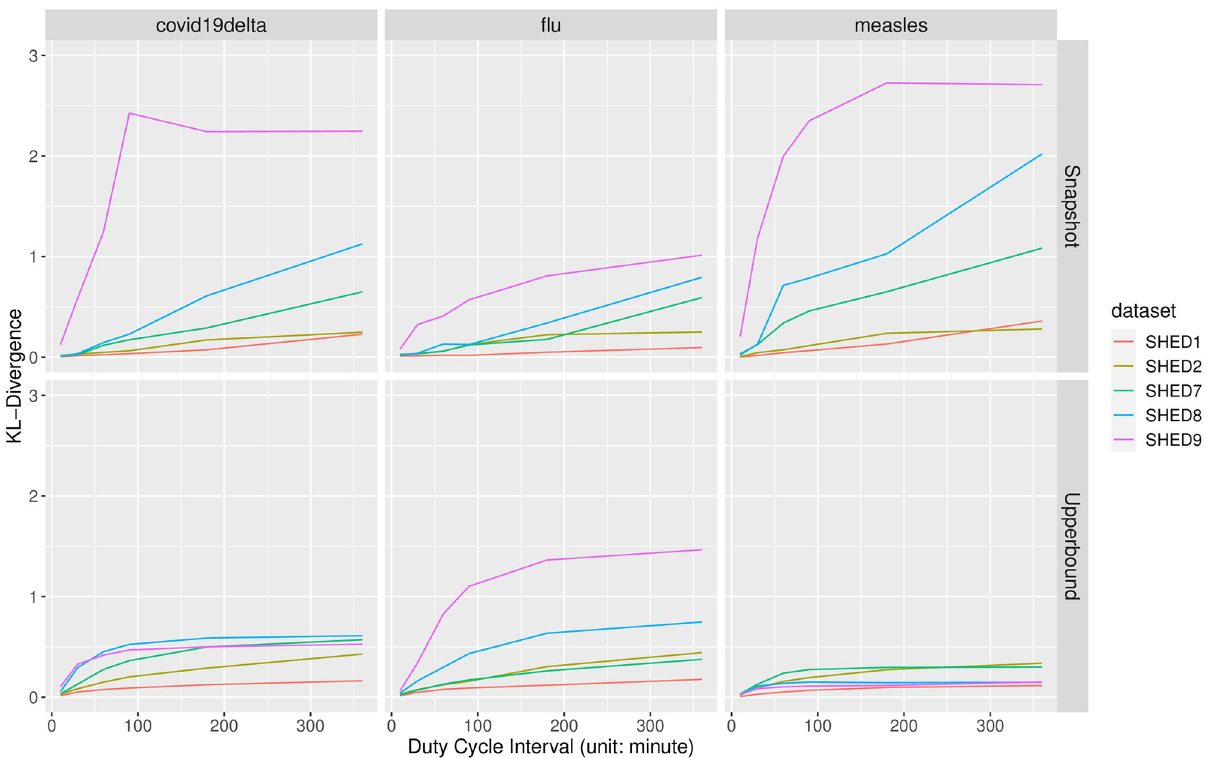
Fig 10. Kullback-Leibler divergence of individual infection risk. The deviation of individual infection risks as sample interval ξ increases is visualized as a grid of line plots. Every cell of the grid corresponds to a specific downsampling method η (row), disease M (column). Within each cell, there are five lines with distinct colors; each color denotes a corresponding underlying population V . Each colored line is formed by sequentially connecting adjacent points with straight lines. There are six points for each colored line, each associated with a sample interval in the order of ξ + = 10, 30, 60, 90, Þ from ρ ð M ; D Þ with the sample interval ξ + 180, 360, denoting the KL-divergence of the baseline ρ ð M ; D x 0 ; Z x þ ; Z